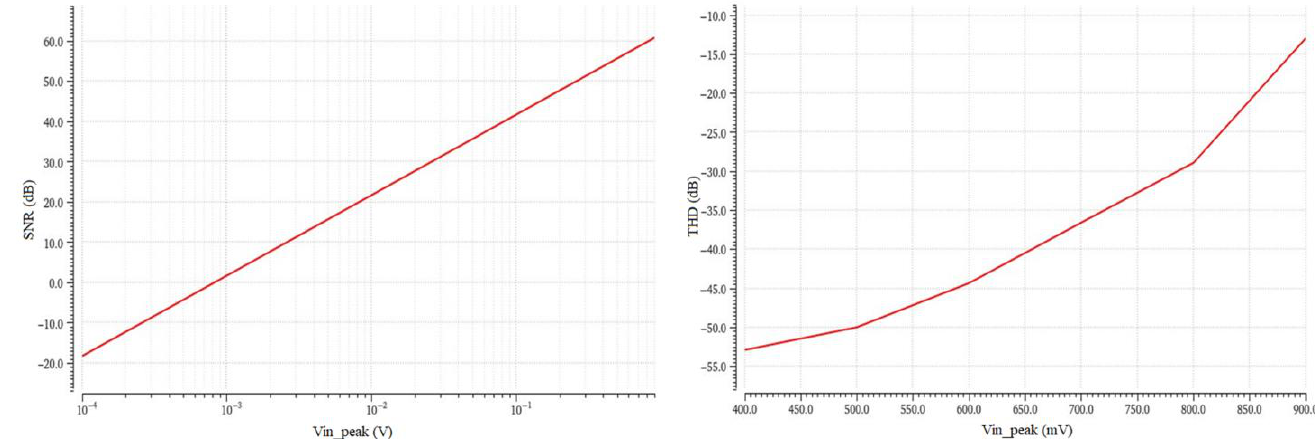
Figure 14. Signal-to-Noise Ratio (SNR) vs. V in_peak and Total Hamonic Distortion vs. V in_peak for the leapfrog topology. Table 8. Corner analysis for the midband gain.